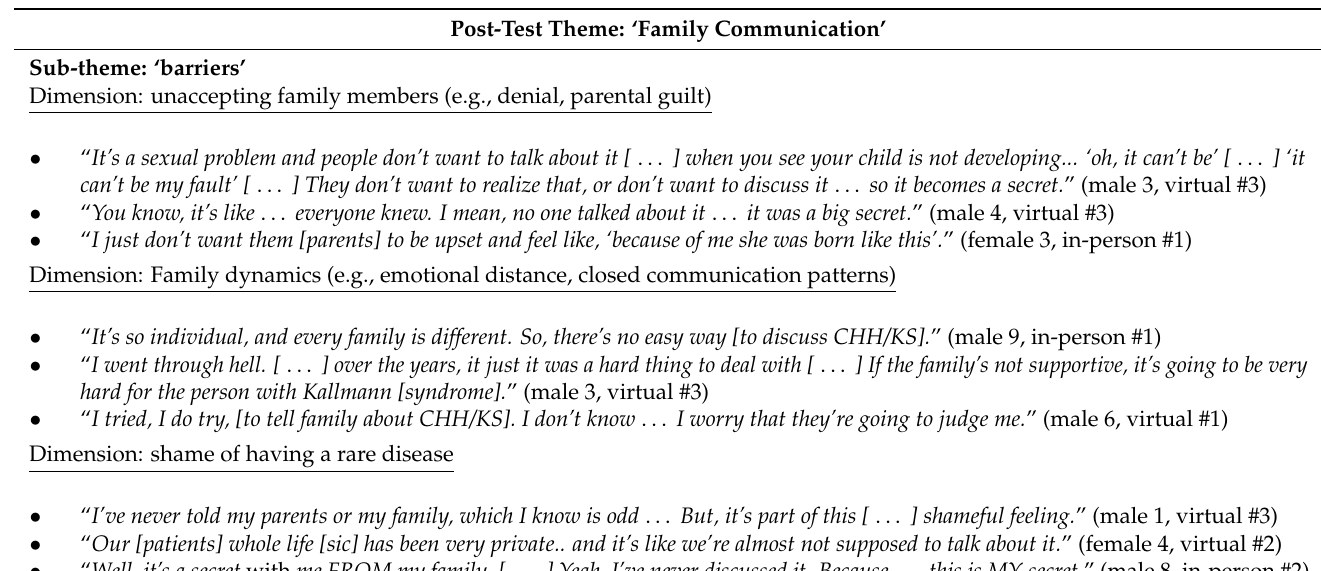
Table 5. Representative quotes relating to post-test experiences: ‘family